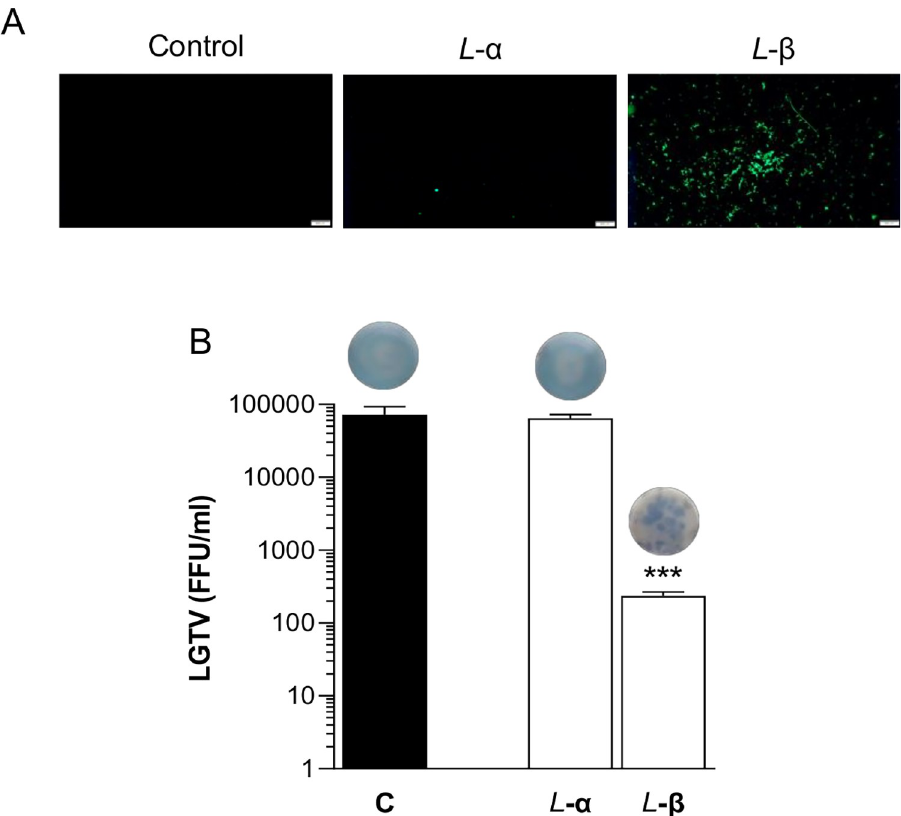
Fig 2. PLNC8 β alone, but not PLNC8 α , shows antiviral properties. LGTV (1 × 10 5 ) were either left untreated or exposed to PLNC8 α or PLNC8 β at a final concentration of 20 μ M. A- Sytox Green staining, 2 h post-treatment, shows permeabilization of LGTV by PLNC8 β . Scale bar is 200 μ m. B- LGTV was incubated in cell culture media containing 20 μ M of either PLNC8 α or PLNC8 β for 1 h at 37˚C, followed by infection of Vero cells for 1 h. Viral load was quantified by performing an immunofocus-based plaque assay. Representative images of the virus plaques are presented above the bars. The virus particles are rapidly permeabilized by PLNC8 β , but not PLNC8 α , and decreased the viral load by > 99%. The data (n = 3) are presented as mean with SEM and analysed using one-way ANOVA with Dunnett´s multiple comparison test ( ��� p < 0.001).